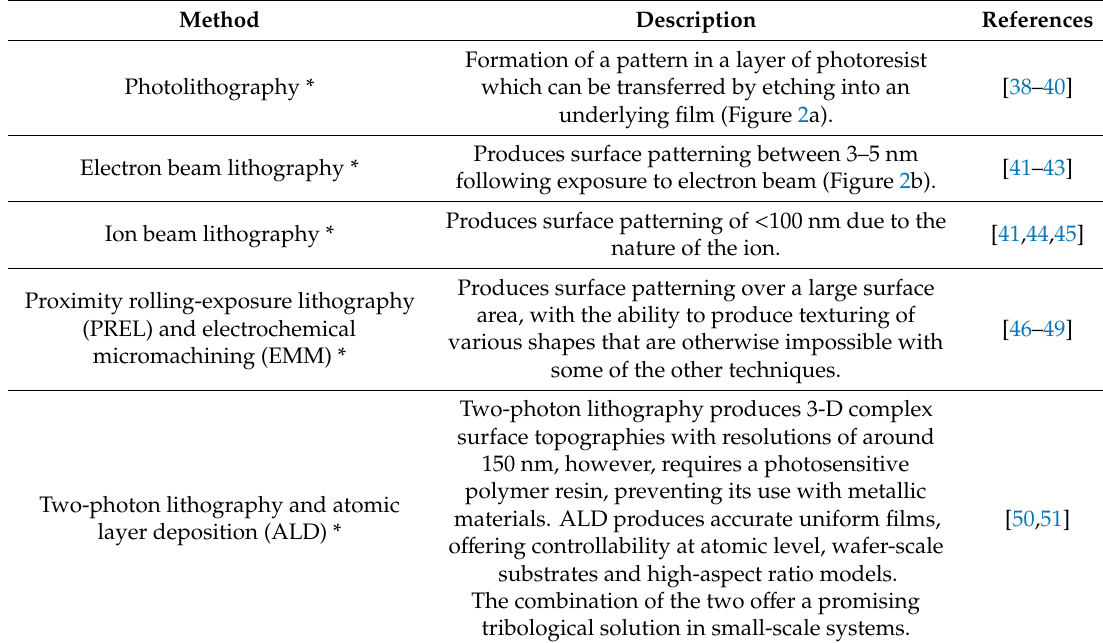
Table 1. Summary of manufacturing methods commonly used for the production of nano- and micro-scale textured